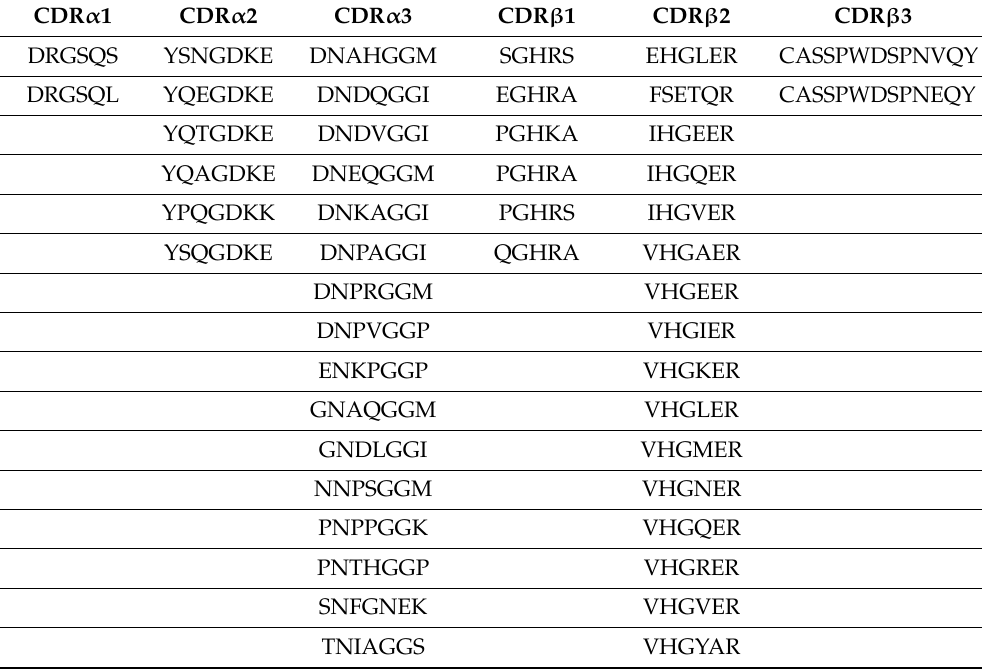
Table 2. CDR sequences for the combinatorial screening library in CHO